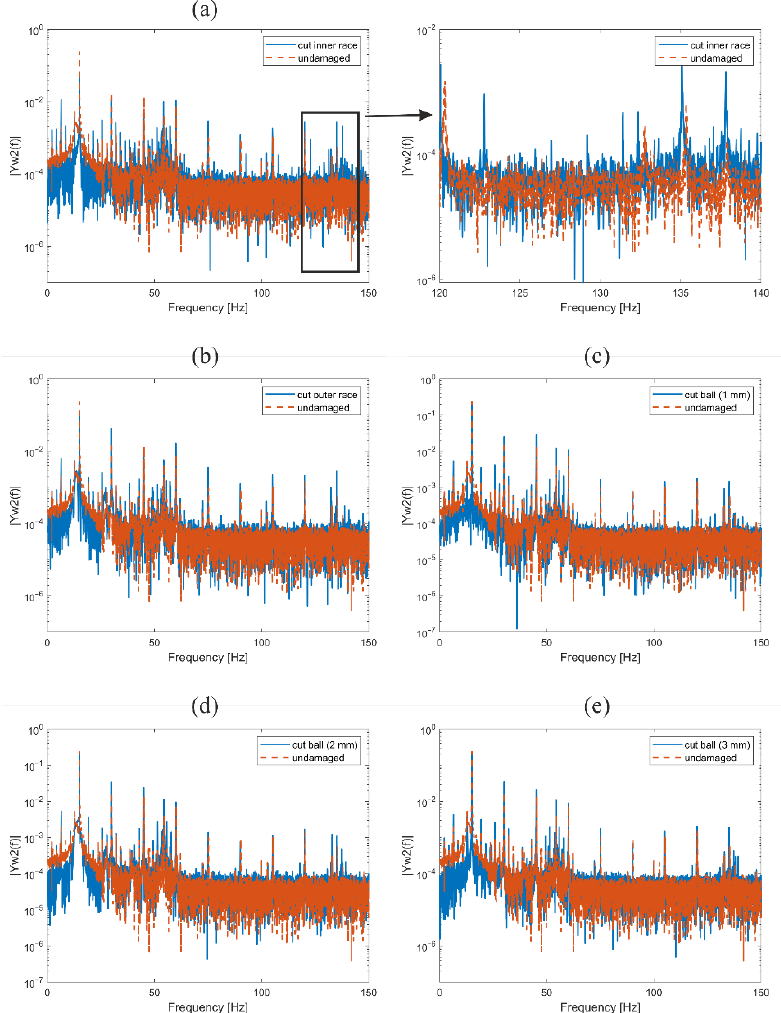
Figure 4. The FFT analysis of the recorded shaft displacement signal influenced by the vibration signal coming from bearing (drive side) SKF 1207K: ( a ) with cut inner race; ( b ) with cut outer race; with the cut ball at the depth of: ( c ) 1 mm; ( d ) 2 mm; ( e ) 3 mm.